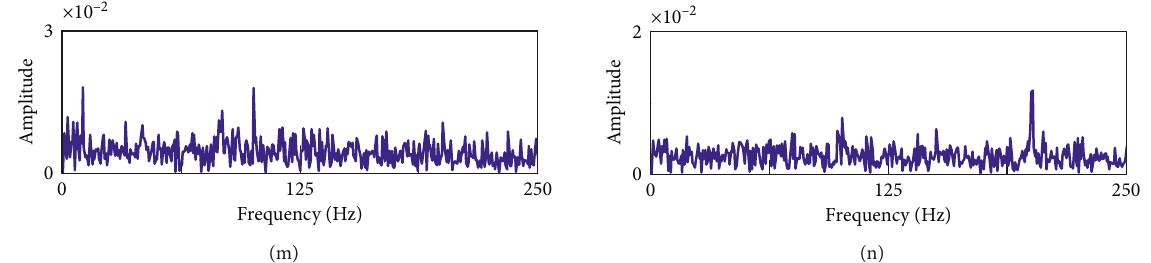
Figure 17: Sub-band signals and their envelope spectra: the left column shows the sub-band signals; the right column shows the squared envelope spectra corresponding to the left column (red dashed lines: f BPFO and its harmonics).